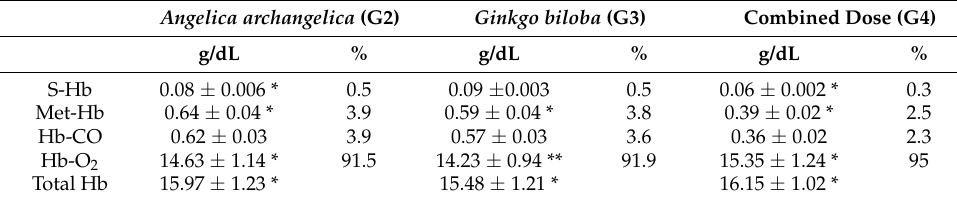
Table 2. Hemoglobin derivative concentrations in rabbits injected with 2 MBq/kg Gallium-68 after seven days of protective oral antioxidant treatment as indicated (G2–G4) (Mean ± SE).